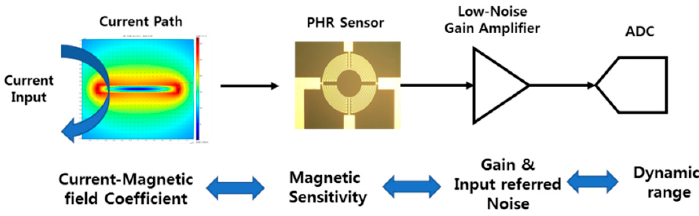
Figure 5. Design parameters in the signal chain of the current sensor.